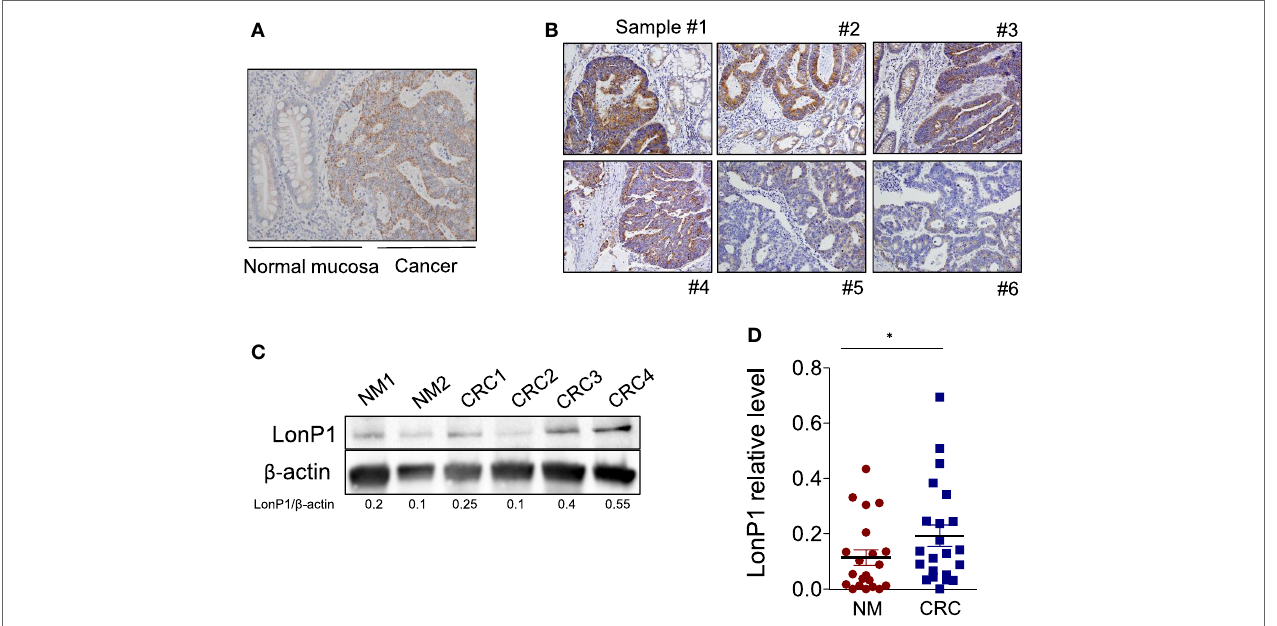
FigUre 2 | LonP1 is upregulated in CRC tissues. (a) Representative immunohistochemical staining of LonP1 in paraffin-embedded human colorectal cancer (CRC) tissue and patient-matched adjacent normal mucosa. (B) Representative immunohistochemical stainings of LonP1 high or low level overexpression in paraffin- embedded human CRC tissues. (c) Representative Western blot analysis of LonP1 expression in CRC tissues and normal mucosa. (D) Relative protein levels of LonP1 are significantly higher in CRC tissues than in adjacent normal mucosa. Data are reported as mean ± SD ( n = 21); * P <